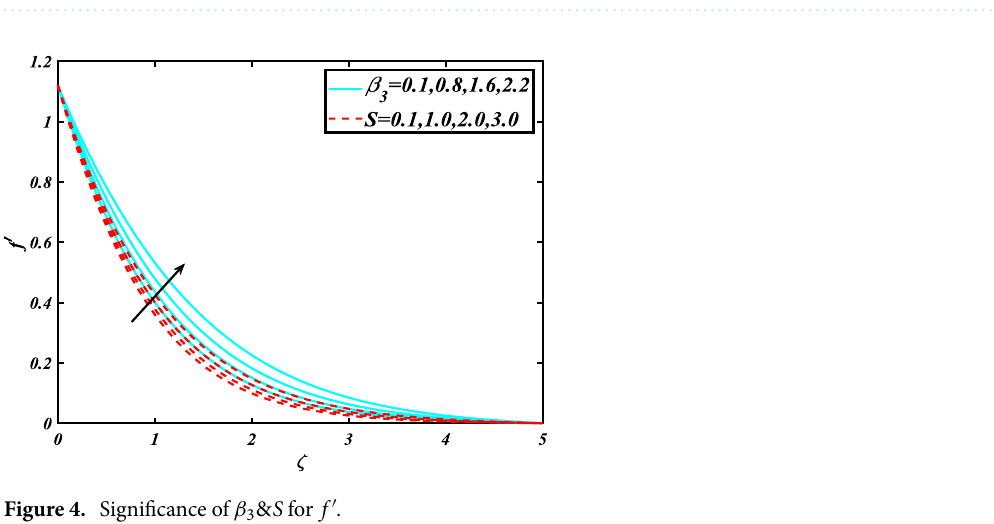
Figure 4. Significance of β 3 & S for f ′